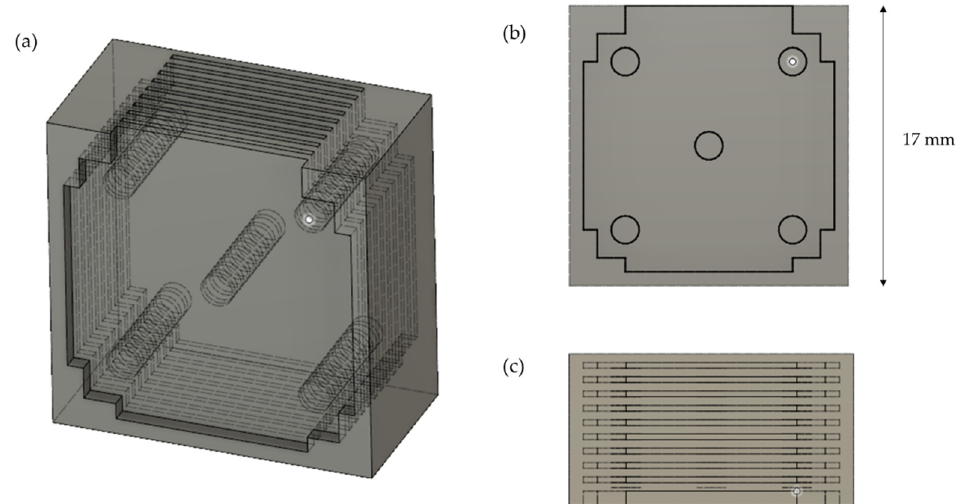
Figure 2. Plate design. ( a ) Plate design: 3D view. The overall dimensions of the object are 17 mm × 17 mm × 14 mm. ( b ) Plate design: front view. The xy-positions of the holes ( ϕ = 4 mm) are indicated. ( c ) Plate design: top view. The holes go through all the plates so that the carbon object will be a single body. The empty space between two consecutive plates is 0.4 mm.